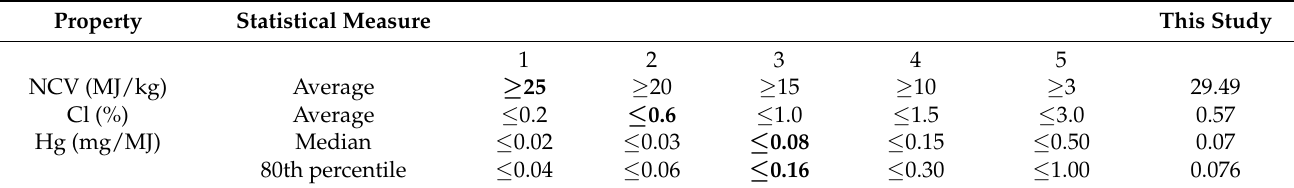
Table 4. Classification of RDF from this study according to EN 15359:2011.